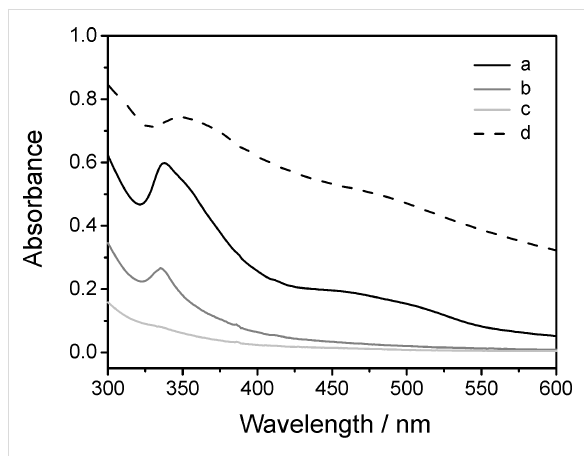
Figure 5: UV–vis spectra of the water solution of C 60 produced by stir- ring C 60 in 6mM γ -CD solution in DMF/toluene (v/v 1:1) at rt for 7 d, fol- lowed by dissolution of the resulting complex in water after evapor- ation of the solvents (procedure c ): (a) before filtration, (b) after filtra- tion, and (c) after centrifugation; (d) n C 60 made from THF [43] before